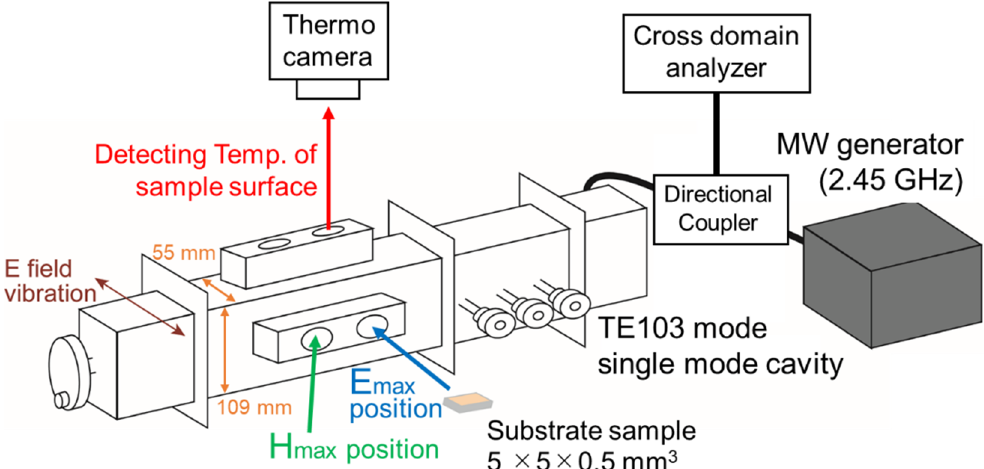
Figure 1. Set up for microwave (MW) heating experiment with substrate sample.